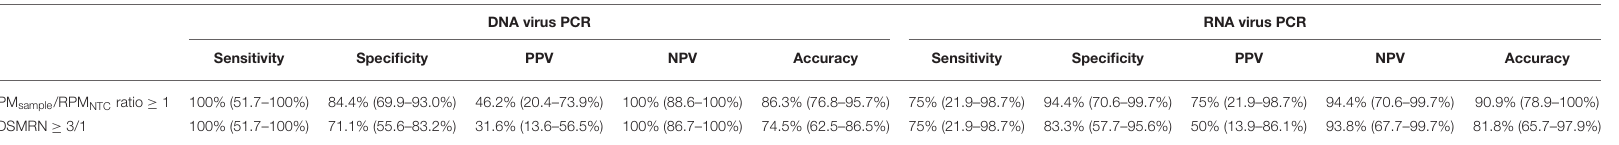
TABLE 5 | Performance of metagenomic sequencing for virus